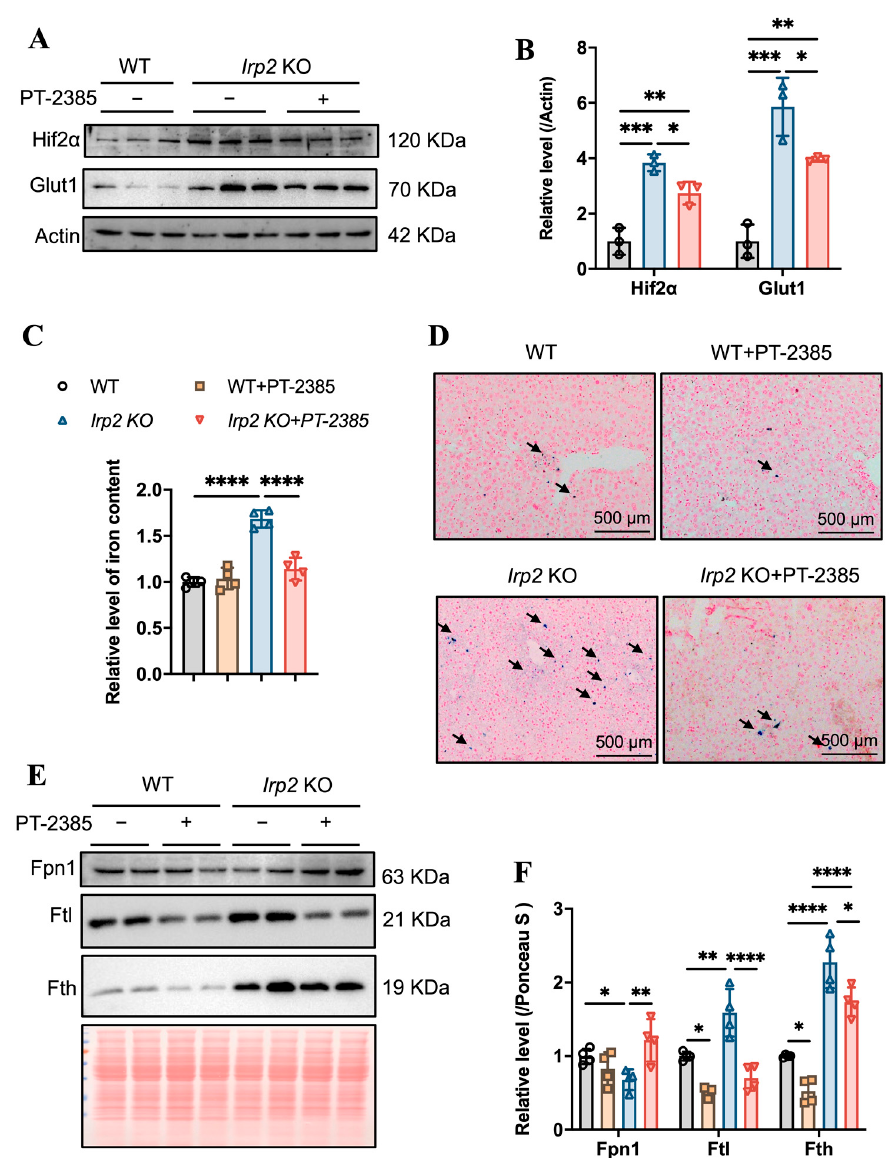
Figure 5. PT–2385 treatment inhibits iron accumulation in the liver. ( A ) Protein levels of Hif2 α and Glut1 revealed by Western blot analysis. Actin was used as internal control. ( B ) Quantification of ( A ) to show significance. ( C ) Ferrozine-based iron content in the liver. ( D ) Prussian blue staining of liver sections. Arrows indicate stained iron. ( E ) Iron-related proteins (Fpn1, Fth, and Ftl) detected by Western blot analysis. Ponceau S stain was used as an internal control. ( F ) Quantification of ( E ) to show significance. n ≥ 3. Results are shown as mean ± SD. One-way ANOVA was used for significance. * p < 0.05, ** p < 0.01, *** p < 0.001, **** p <